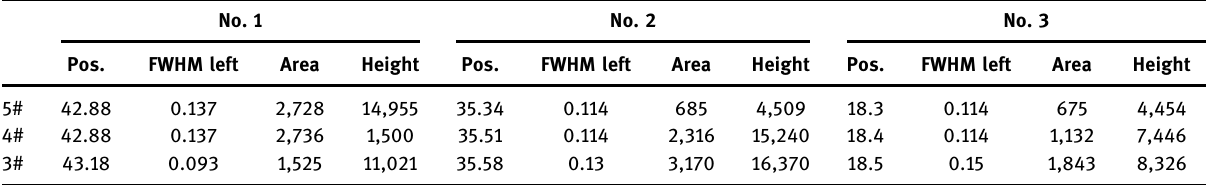
Table 3: Di ff raction peak analyses of acid leaching products No.